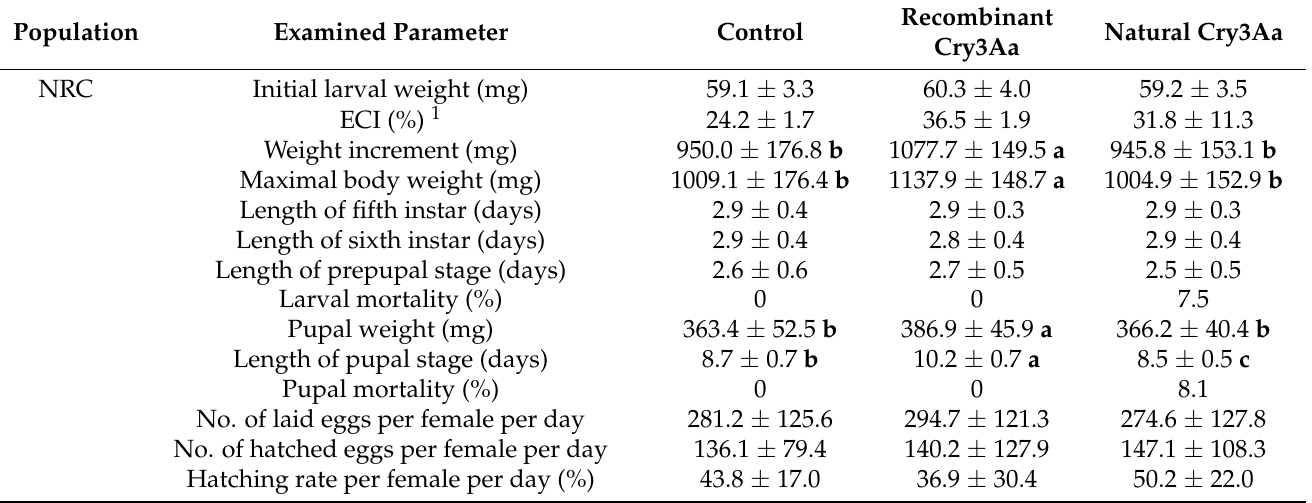
Table 1. Examined parameters (mean ± SD) of three S. littoralis populations in bioassay 2 with 8 µ g/g recombinant and natural Cry3Aa in a semi-artificial diet. Different letters (in bold) denote statistically significant differences, while letters are not assigned when statistical difference was not found. Statistical comparison was performed for recombinant and natural Cry3Aa together. The values of statistical tests are available in Table